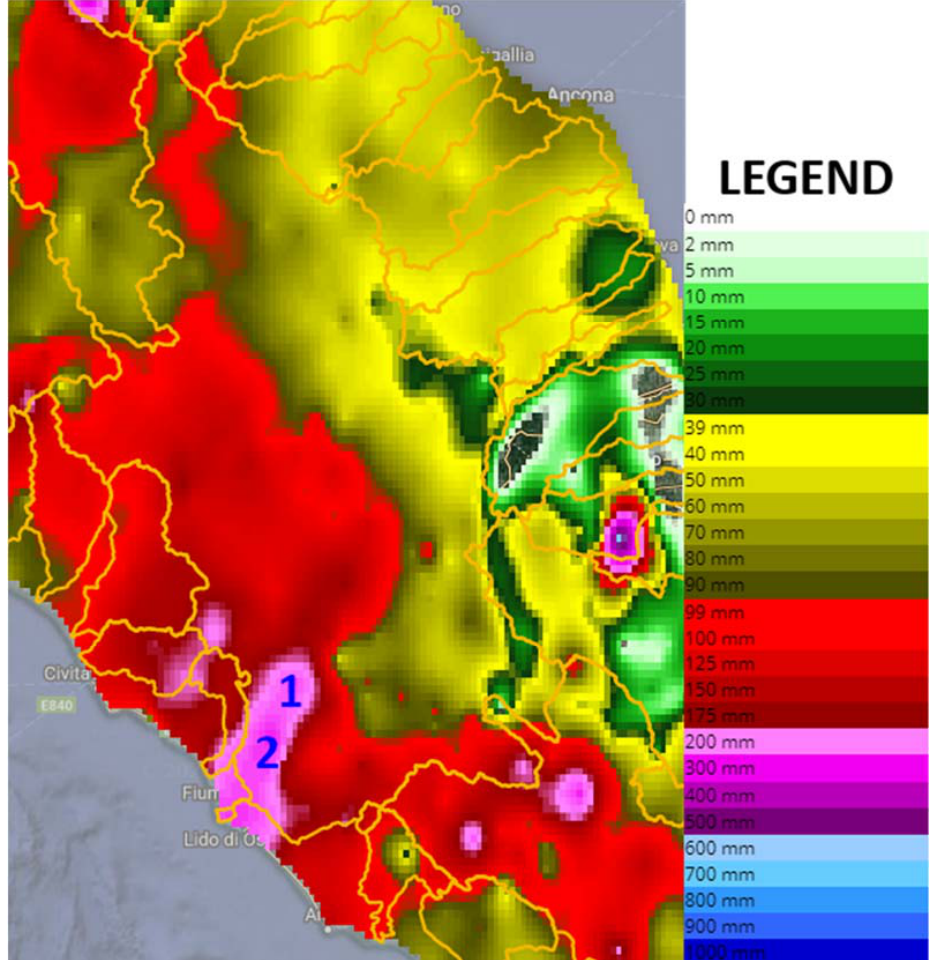
Figure 5. Accumulated rainfall from 30 January to 5 February 2014. The precipitation field is spati- alized over the geographical domain starting from punctual range gauge data. Blue numbers indi- cate the location of the Riano (no. 1) and Ottavia (no. 2) rain gauges, where rainfall maxima were recorded. The image is taken from the Dewetra platform [27] (Accessed 31 July 2022). Damage was reported in 80 Lazio municipalities, including destruction of infrastruc- ture due to wet mass movement (impassable roads, unsafe buildings, damages to sewer systems, interruption of electrical infrastructure) and flooding. Local authorities decided to evacuate more than 500 people. The Corbara, Alviano, Ponte Felice, Nazzano, and Cas- tel Giubileo dams were forced to conduct flood lamination draining operations. The re- port of the Lazio Functional Center only provides information about operations at the Corbara and Alviano reservoirs. In particular, the Corbara Dam, located in the upper Ti- ber catchment, discharged up to 700 m 3 /s downstream to the middle course of the river between 31 January and 2 February. The Alviano reservoir released almost 1,000 m 3 /s in the same period. Critical water level thresholds have been defined by civil protection authorities for 34 hydrometric stations across the three basins. During the event, 8 stations recorded hy- drometric levels exceeding the ordinary threshold (OT), 11 exceeded the moderate thresh- old (MT), and 10 exceeded the high threshold (HT). The water level time series for the remaining sensors remained below the OT (Figure 6).